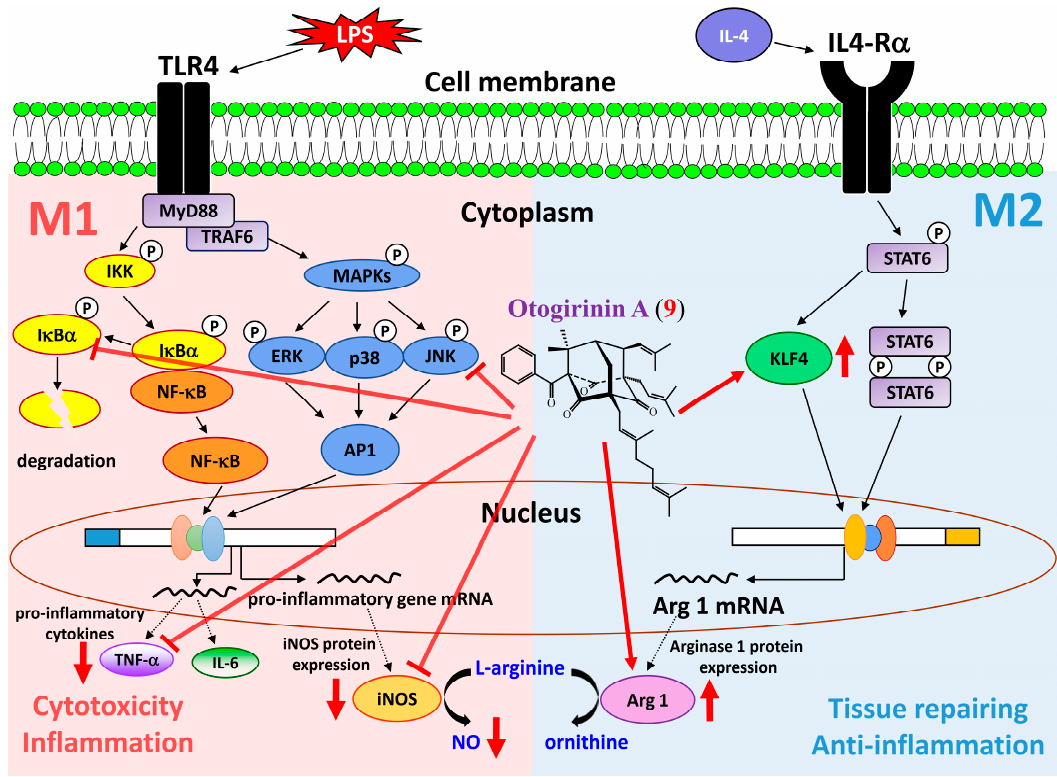
Figure 12. Schematic diagram for anti-inflammatory action of otogirinin A ( 9 ) in LPS-induced RAW264.7